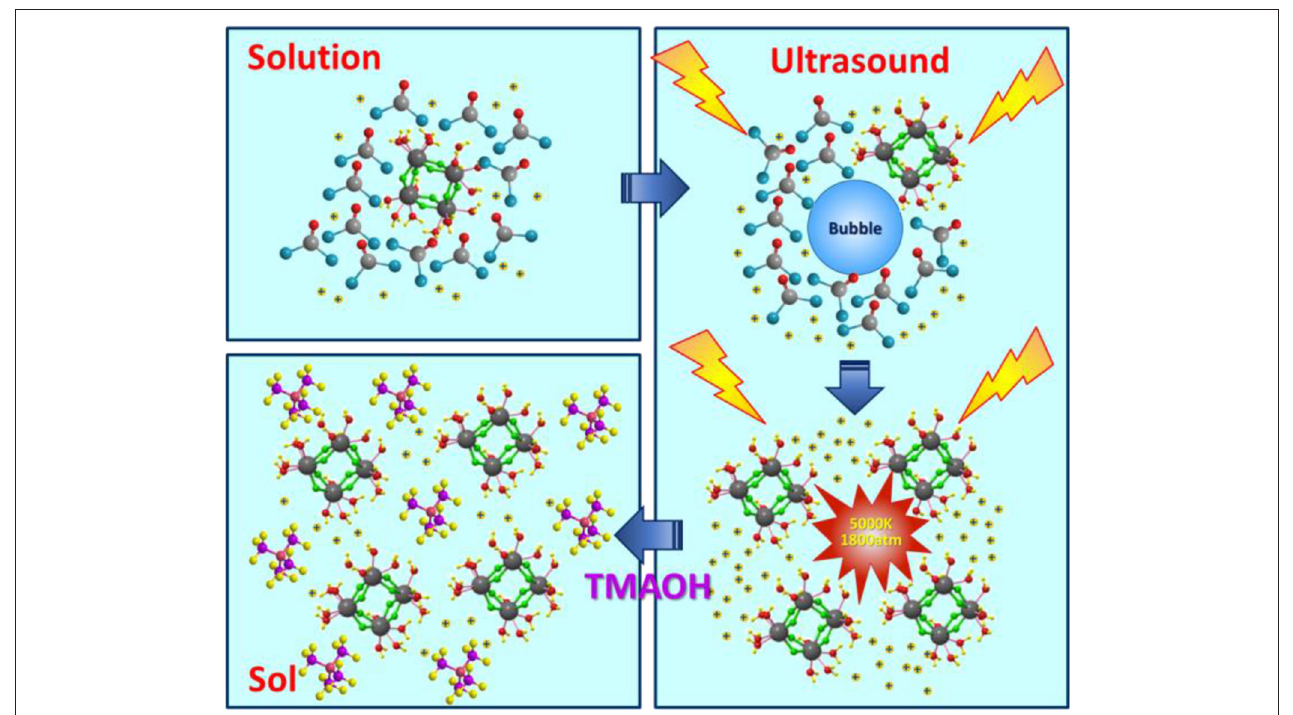
FIGURE 1 | Reaction mechanism of ultrasound assisted synthesis method.